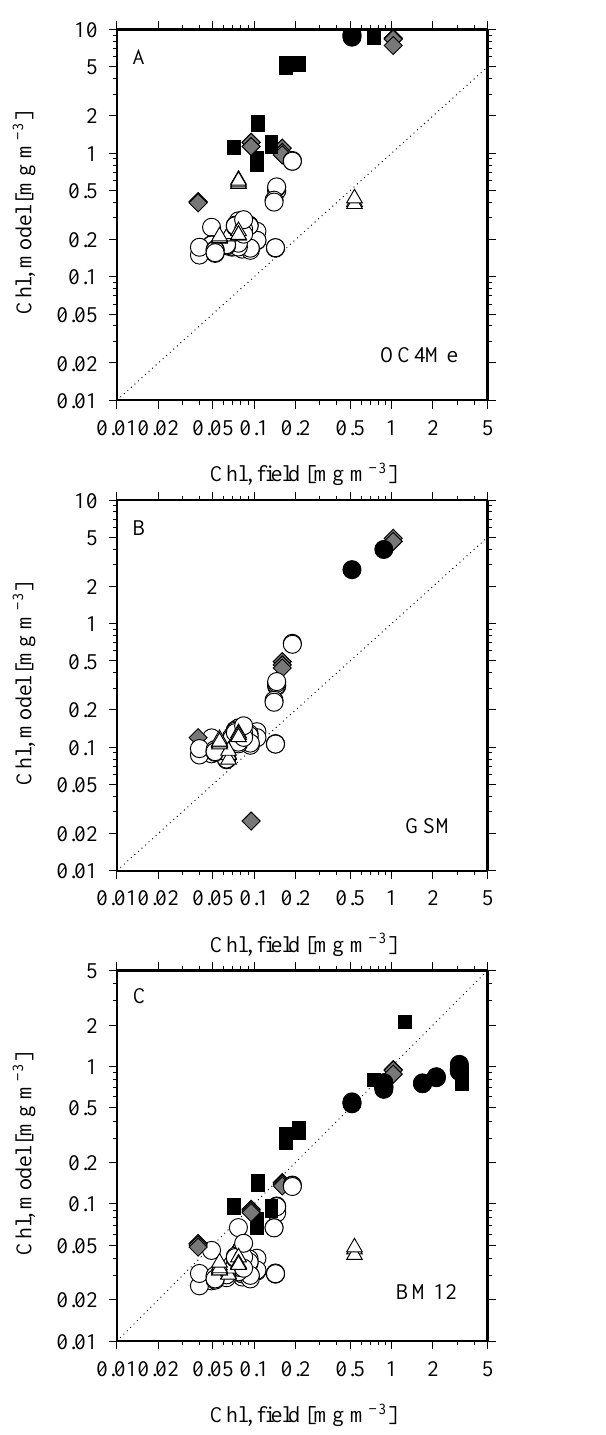
Fig. 8. Chl concentrations retrieved from (A) OC4Me, (B) GSM and (C) Ben Mustapha et al. (2012) algorithms (see text), as a function of the Chl value determined from field samples.